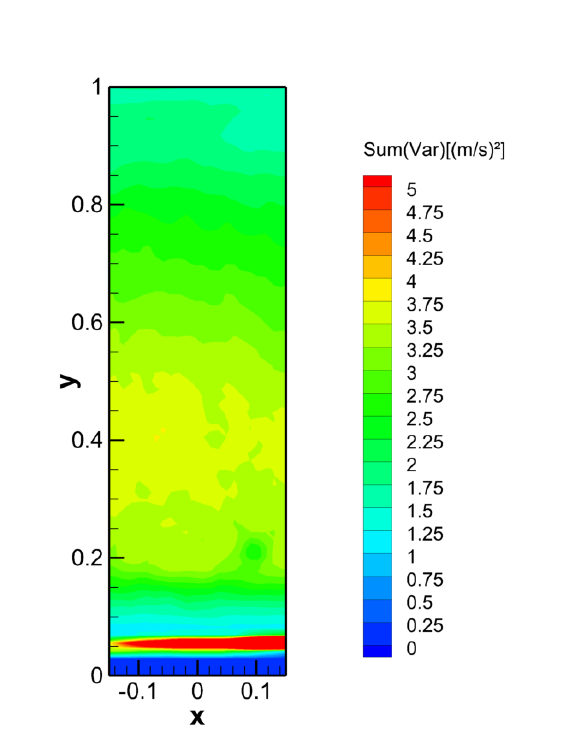
Fig. 5. Sum of in-plane velocity components variances distribution .